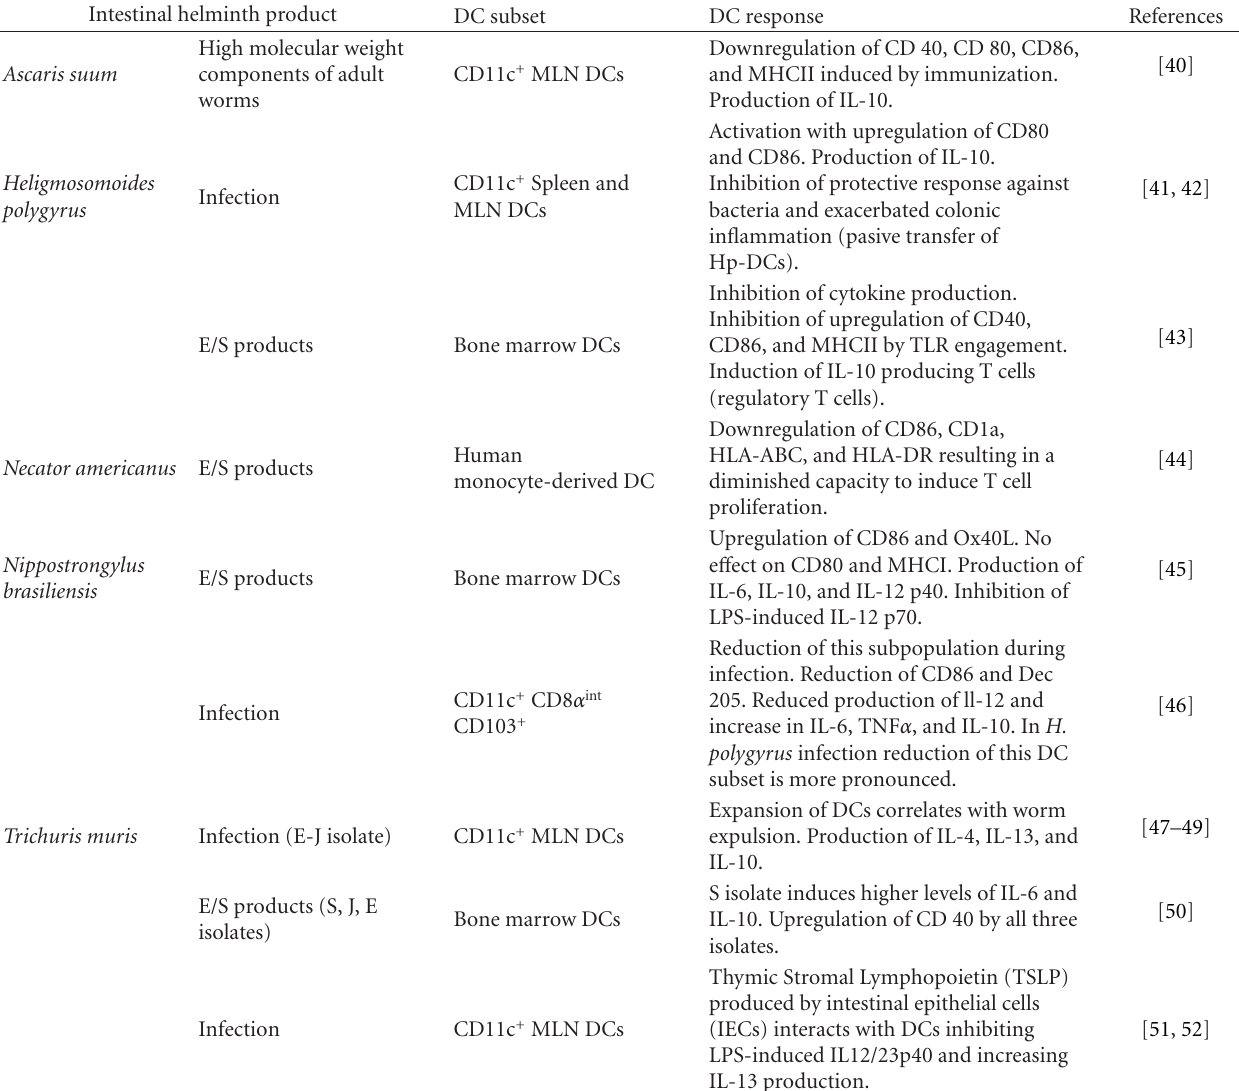
Table 2: E ff ect of intestinal helminth infections or their products on DC